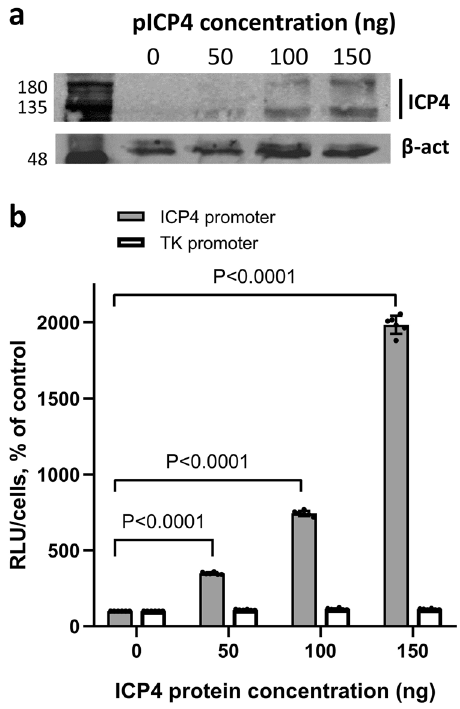
Fig. 4 G4-mediated ICP4 promoter regulation by ICP4 in cells. a Western blot analysis of ICP4 expression in the presence of increasing amounts of ICP4 expression plasmid in transfected U-2 OS cells. ICP4 and TK promoters were cloned in the promoterless pGL-4.10 plasmid upstream of the luciferase gene and transfected into U-2 OS cells. β -actin was used as housekeeping control for cell amount. Two independent experiments were performed with one replicate per condition in each experiment. b Luciferase reporter assay of ICP4 and TK promoter activity in the presence of increasing amounts of ICP4 protein from ICP4 expression plasmid. Two independent experiments were performed with three replicates per condition in each experiment. P -values and SD are